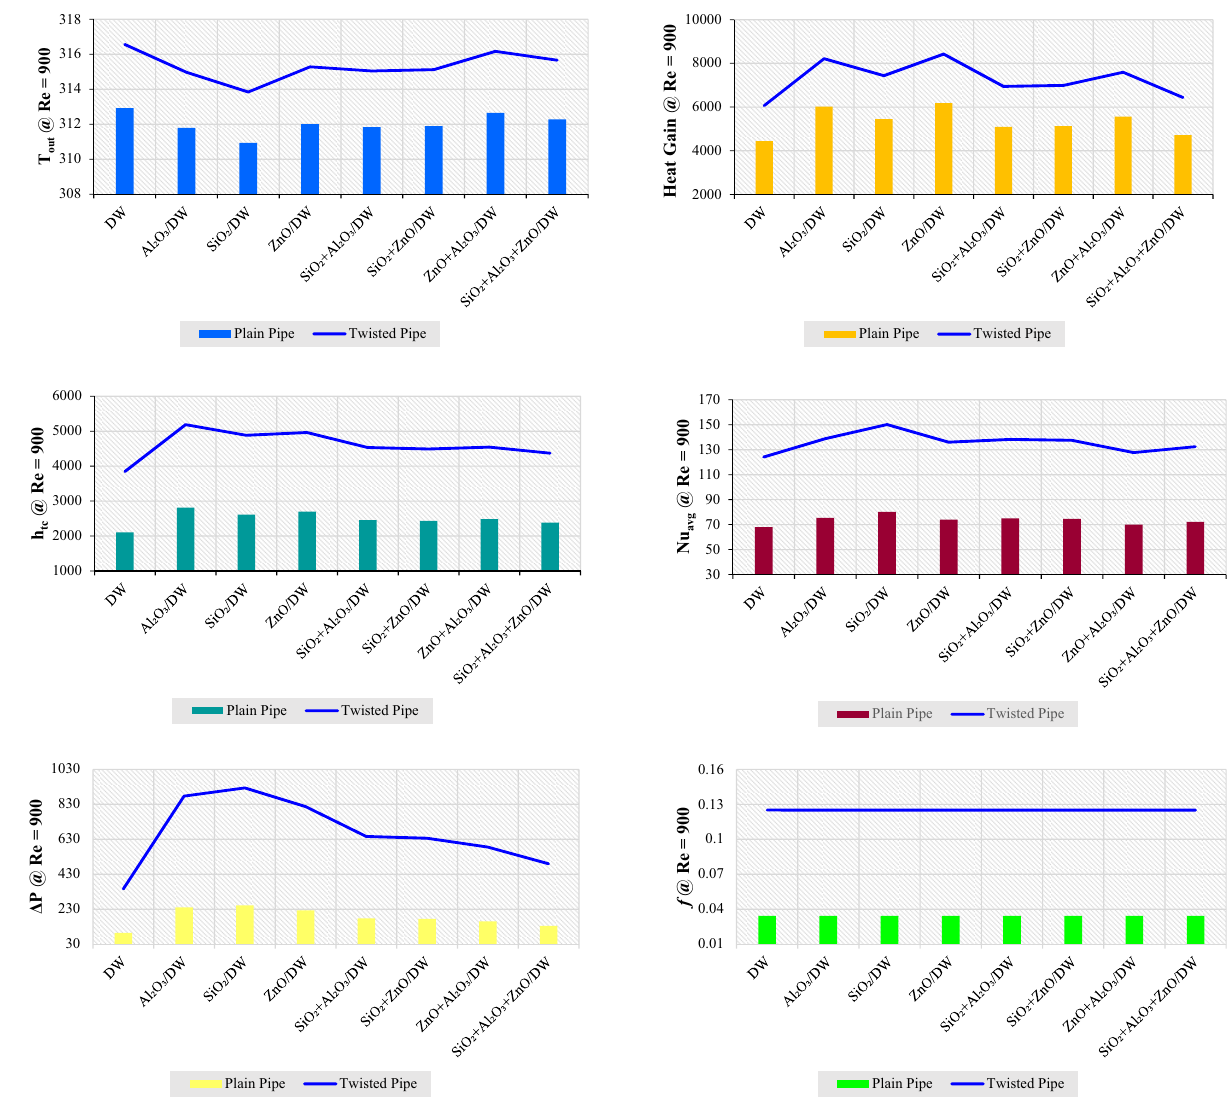
Figure 6: Thermohydraulic parameters of plain and twisted pipes using DW, single, hybrid, and ternary nano fl uids at Re = 900 and